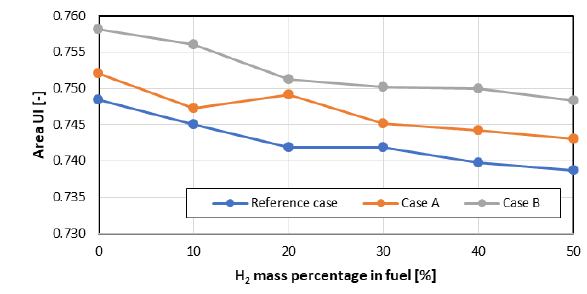
Fig. 11. Area weighted static temperature uniformity index for selected cross